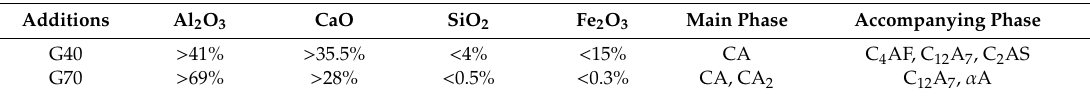
Table 2. Contents of the main components in aluminum calcium cements introduced as additions to